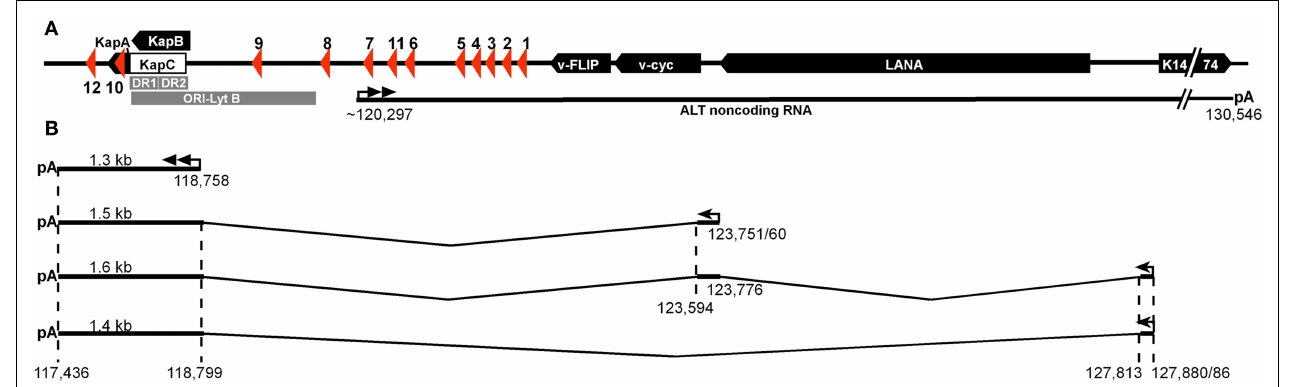
transcript (ALT). (B) Schematic of the KSHV pri-miRNAs, showing exons (thick lines), introns, transcription start sites. In both panels, nucleotide coordinates refer to positions in the KSHV genome (GenBank accession number: U75698.1). Double arrows indicate transcription start site of lytic RNAs, single arrows start sites of latent RNAs.The bottom transcript was detected in BC-1 cells, but not in BCBL-1 cells. (A,B) are drawn approximately to scale and aligned to each